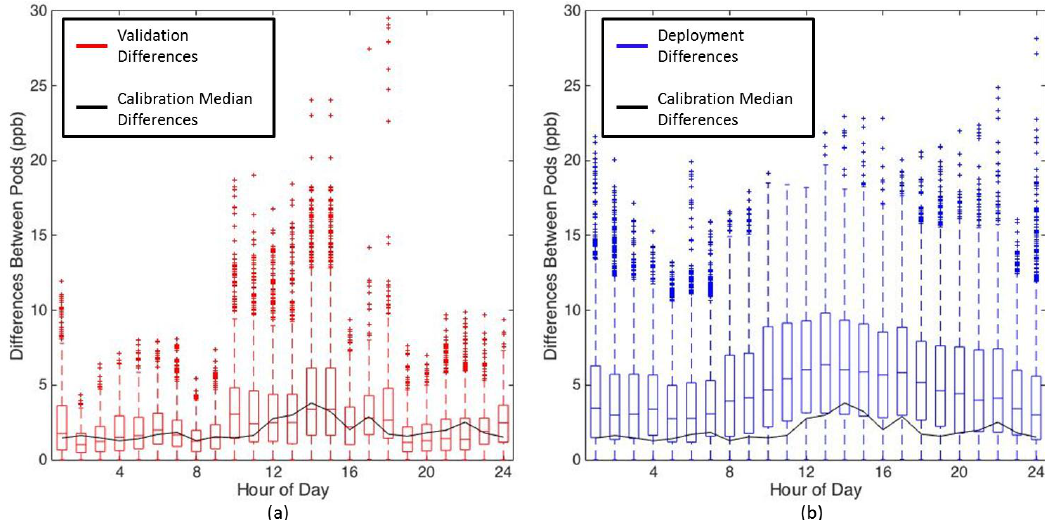
Figure 4. Differences between all SBC UPods binned by hour, with differences displayed as absolute ppb. ( a ) includes the boxplot of the differences during the data validation period (red outlined boxes), and the median differences of the calibration data (solid black line). ( b ) includes the boxplot of the differences during the deployment (blue outlined boxes), and the median differences of the calibration data (solid black line). Whisker lines (red and blue) encompass 1.5 times the interquartile range (IQR), and outliers (red and blue crosses) indicate data points lying outside 1.5 times the IQR of the validation and deployment data, respectively.